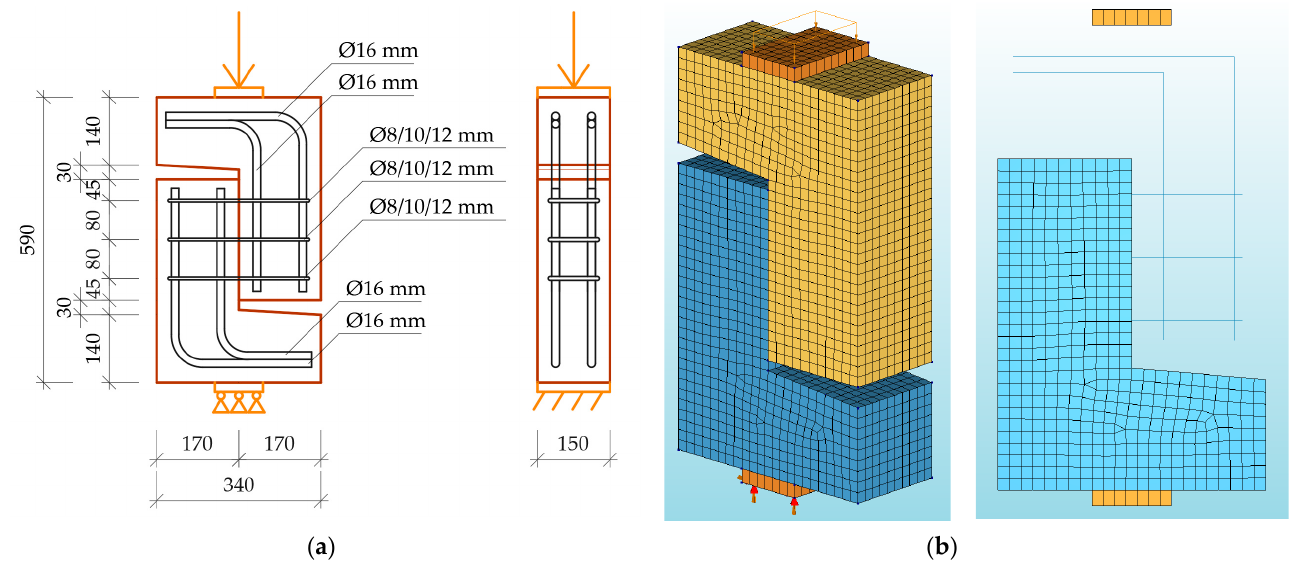
Figure 5. Interface push-o ff test: ( a ) structural model of the push-o ff test; ( b ) numerical model of the push-o ff test.